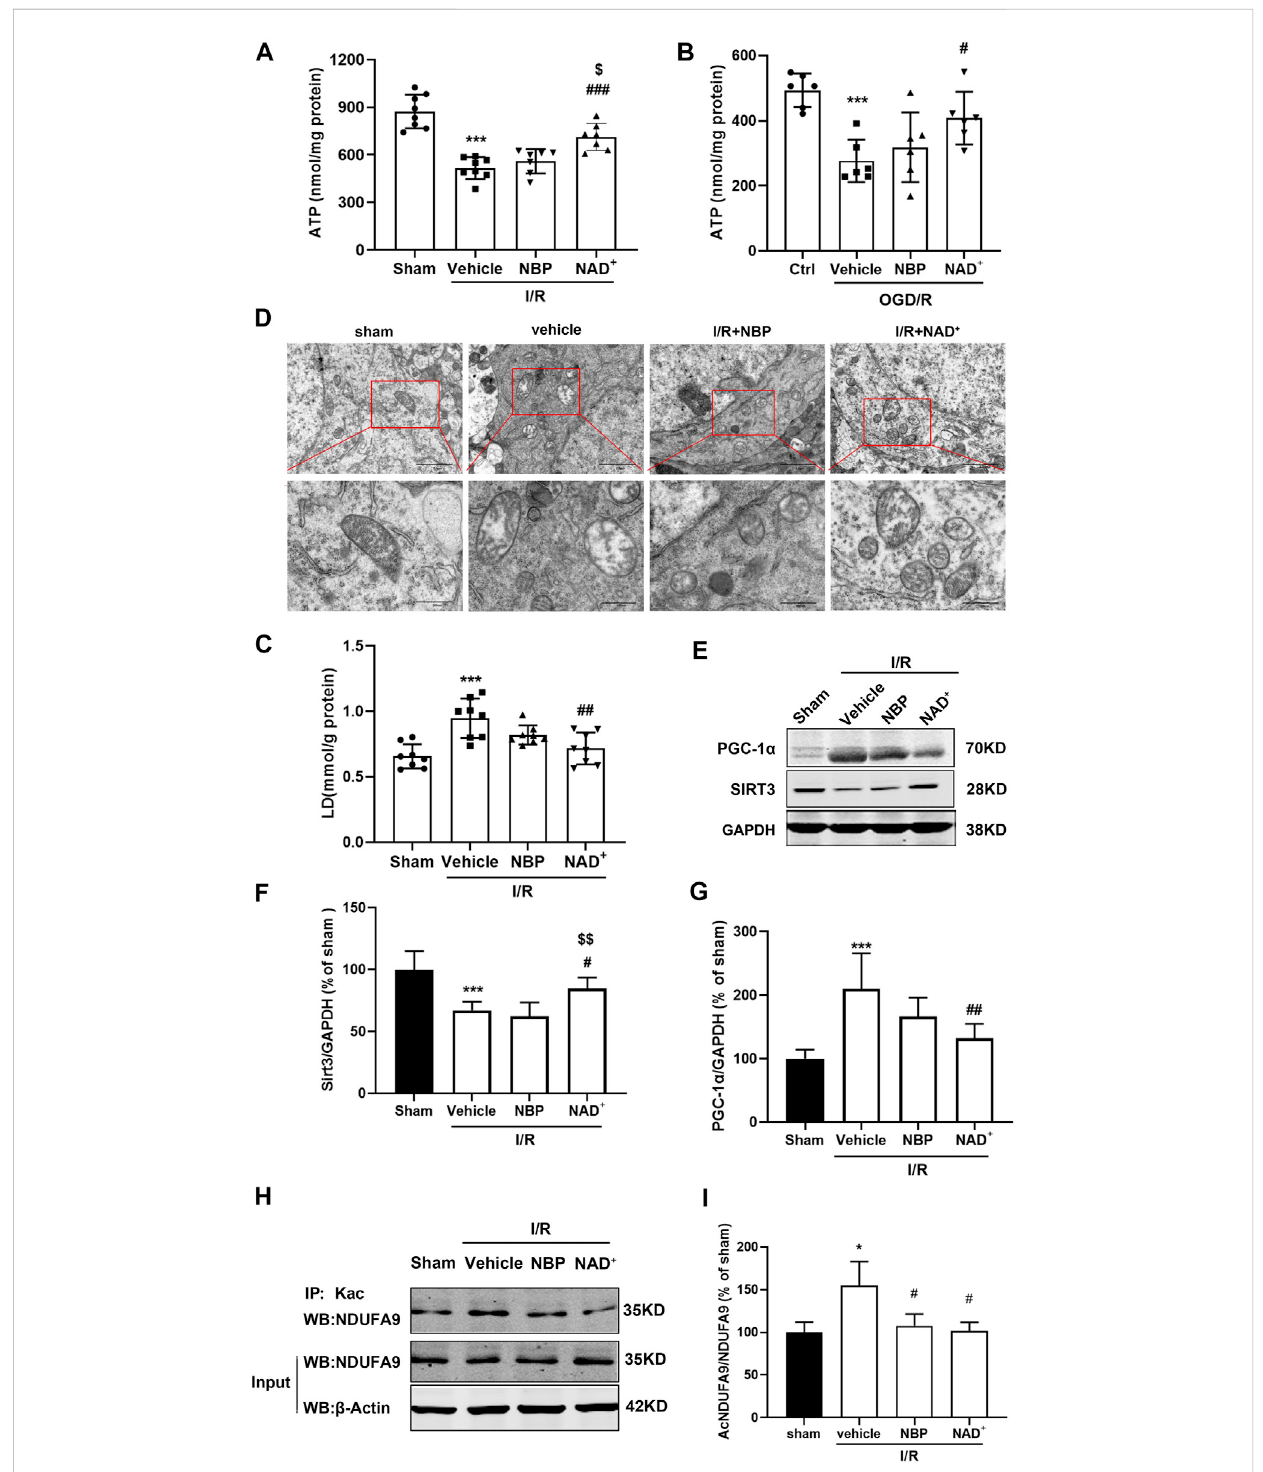
FIGURE 6 NAD + issuperiortoNBPinimprovingenergymetabolism. (A) Inmice, MCAOwasperformedfor 2 h.NAD + andNBPwereadministeredimmediately after reperfusion. ATP levels in cortex 3 h after cerebral ischemia/reperfusion in mice. (B) The primary cortical neurons were treated with 5 μ M NBP and 15 mM NAD + after OGD/R immediately. Neuronal ATP levels were detected with ATP detection kits 3 h after OGD/R. (C) LD levels in cortex 3 h after cerebralischemia/reperfusioninmice. (D) Mitochondrialmorphology inischemicregionwasobservedbytransmission electronmicroscopyafterI/ R. Scale bar = 500 nm. The brain was removed at 24 h after reperfusion. (E, F) Analysis of SIRT3 expression in ischemic cortex. (G) Analysis of PGC-1 α expressioninischemiccortex. (H,I) AnalysisofacetylationofNDUFA9inischemiccortex. ***p < 0.001vs.shamorctrl, # p < 0.05, # p < 0.05, ## p < 0.01and ### p < 0.001 vs.vehicle, $ p < 0.05, $$ p < 0.01vs. NBPby One-way analysis ofANOVA followed byTukey ’ smultiple comparisons test. Data were expressed as the mean ± SD. There were at least six animals or three independent cultures in each